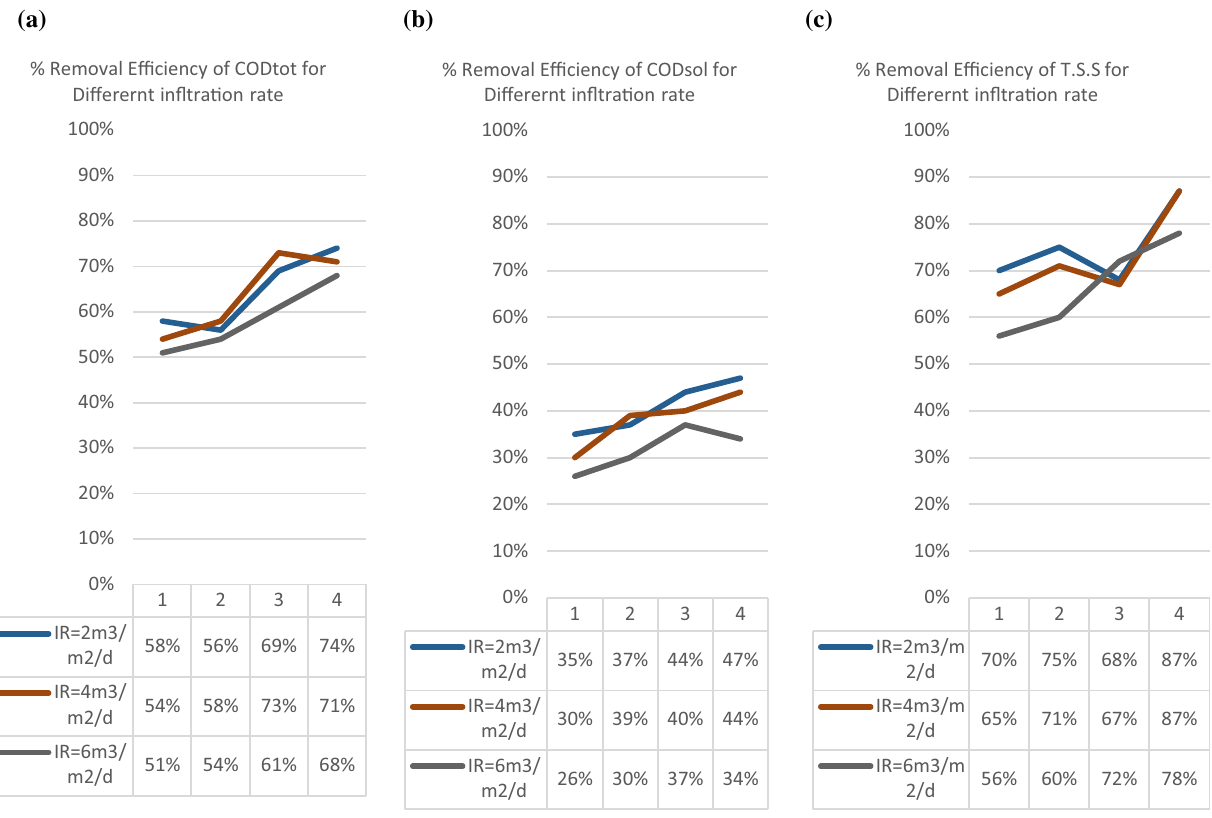
Fig. 13 Results obtained from run (3), a) %R.E. of COD